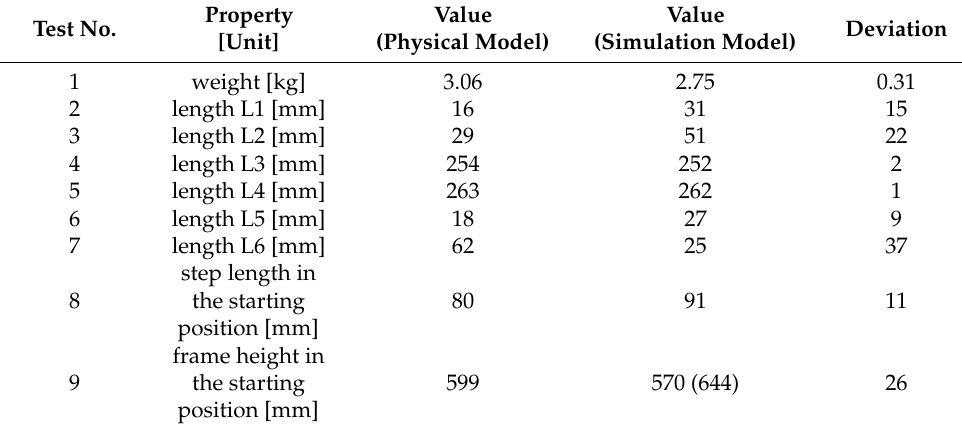
Table 6. Results of testing the dimensions of the biped robot structure. Property Test No.